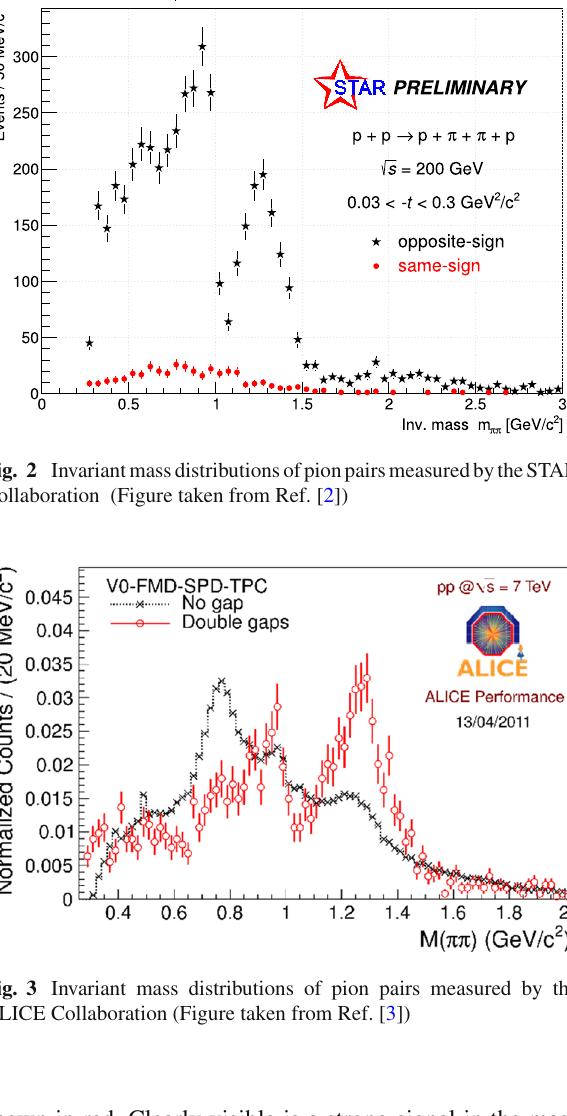
individual resonances (f 0 (980) in yellow, f 2 (1270) in